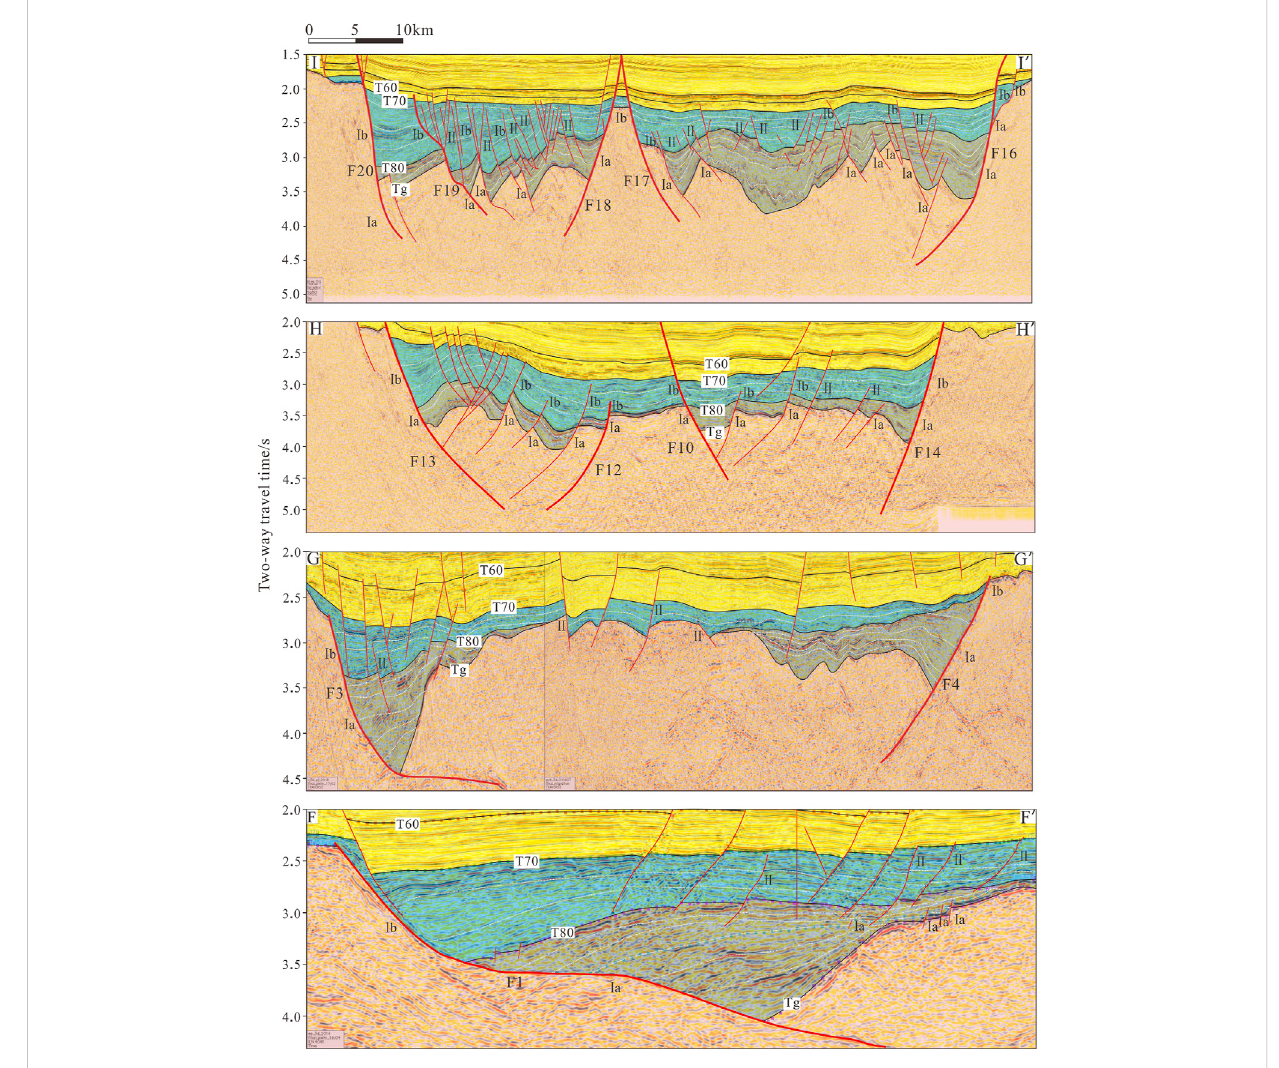
FIGURE 2 Typical seismic pro fi les of fault system in the Zhu Ⅰ Depression (for section locations, see Figure